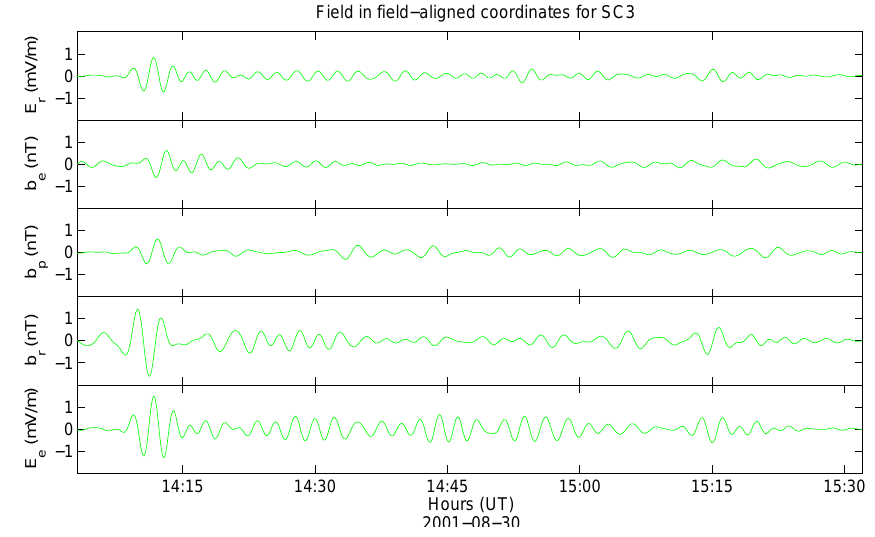
Fig. 6. Field in field-aligned coordinates measured by SC 3. The data have been bandpass filtered in the range 4–9mHz. Here we have not used the E · B = 0